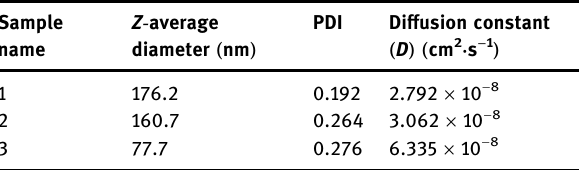
Table 2: Nanoemulsion droplet size distribution values Sample